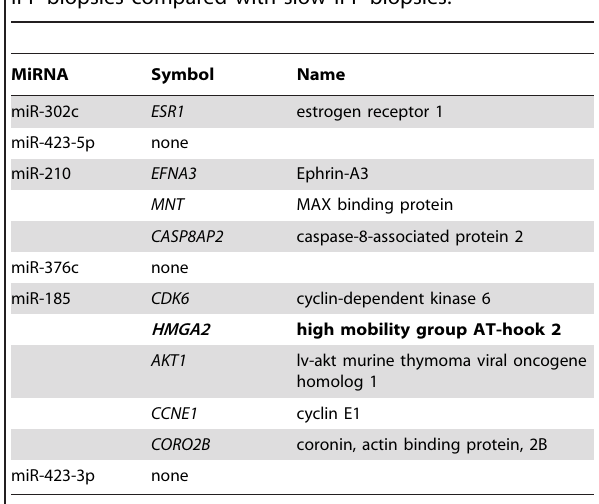
Table 4. List of experimentally validated miRNA gene targets using miRecords, which are increased or decreased in rapid IPF biopsies compared with slow IPF biopsies.